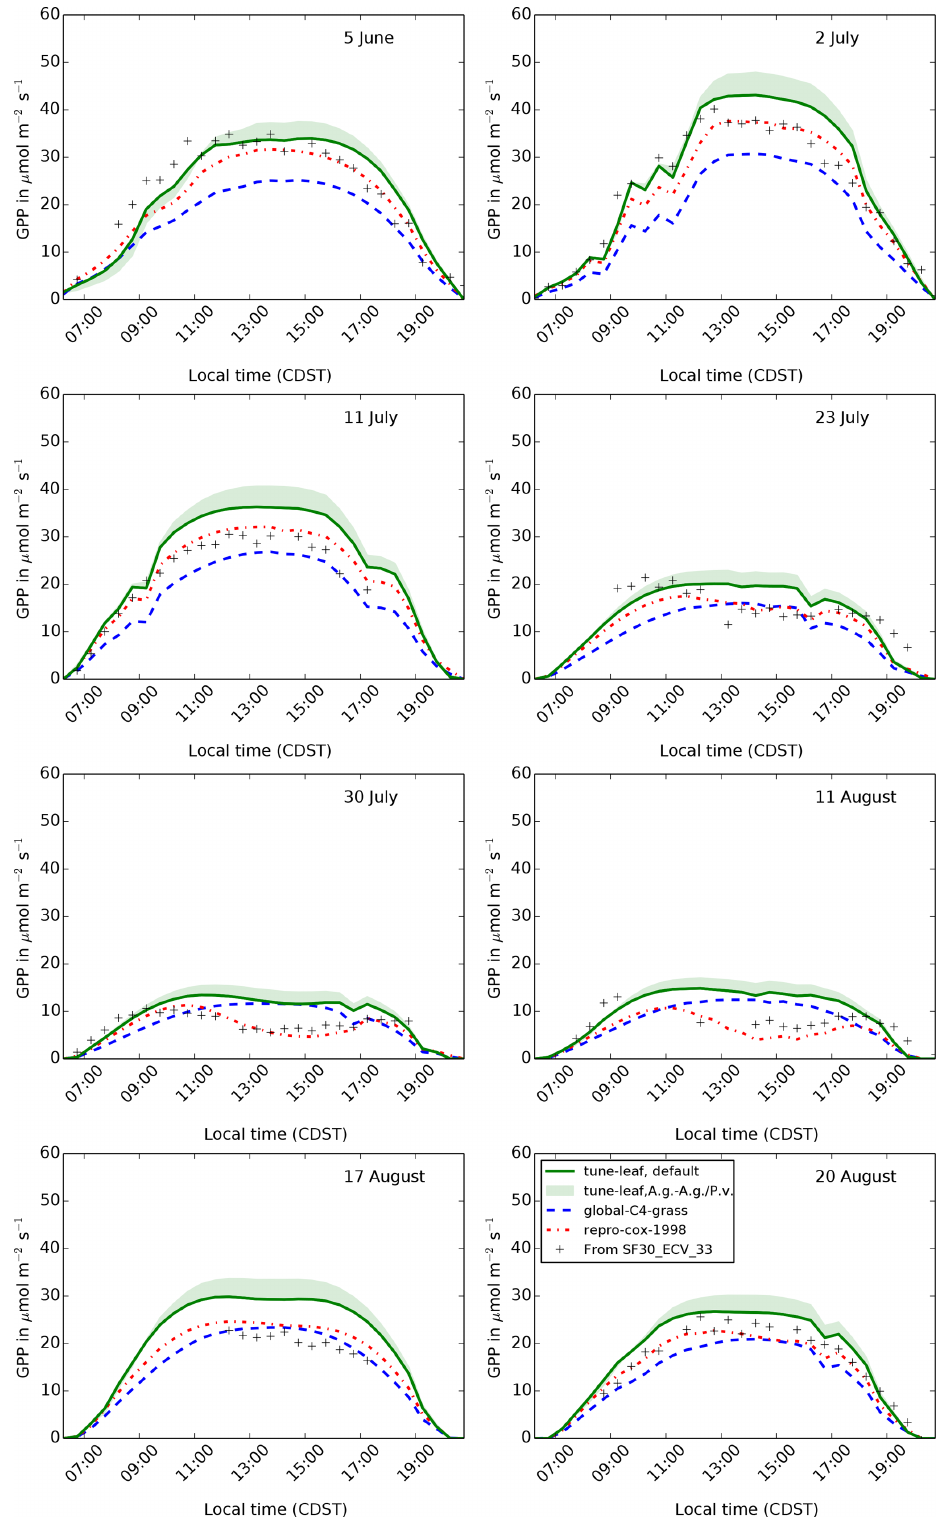
Figure 9. The diurnal cycle of GPP at site 4439 in the FIFE area for 8 days in 1987: 5 June (early growth), 2 and 11 July (peak growth), 23 July, 30 July and 11 August (dry period), and 17 and 20 August (early senescence). Green band shows uncertainty from fitting plant parameters to A. gerardii compared to fitting to both A. gerardii and P. virgatum